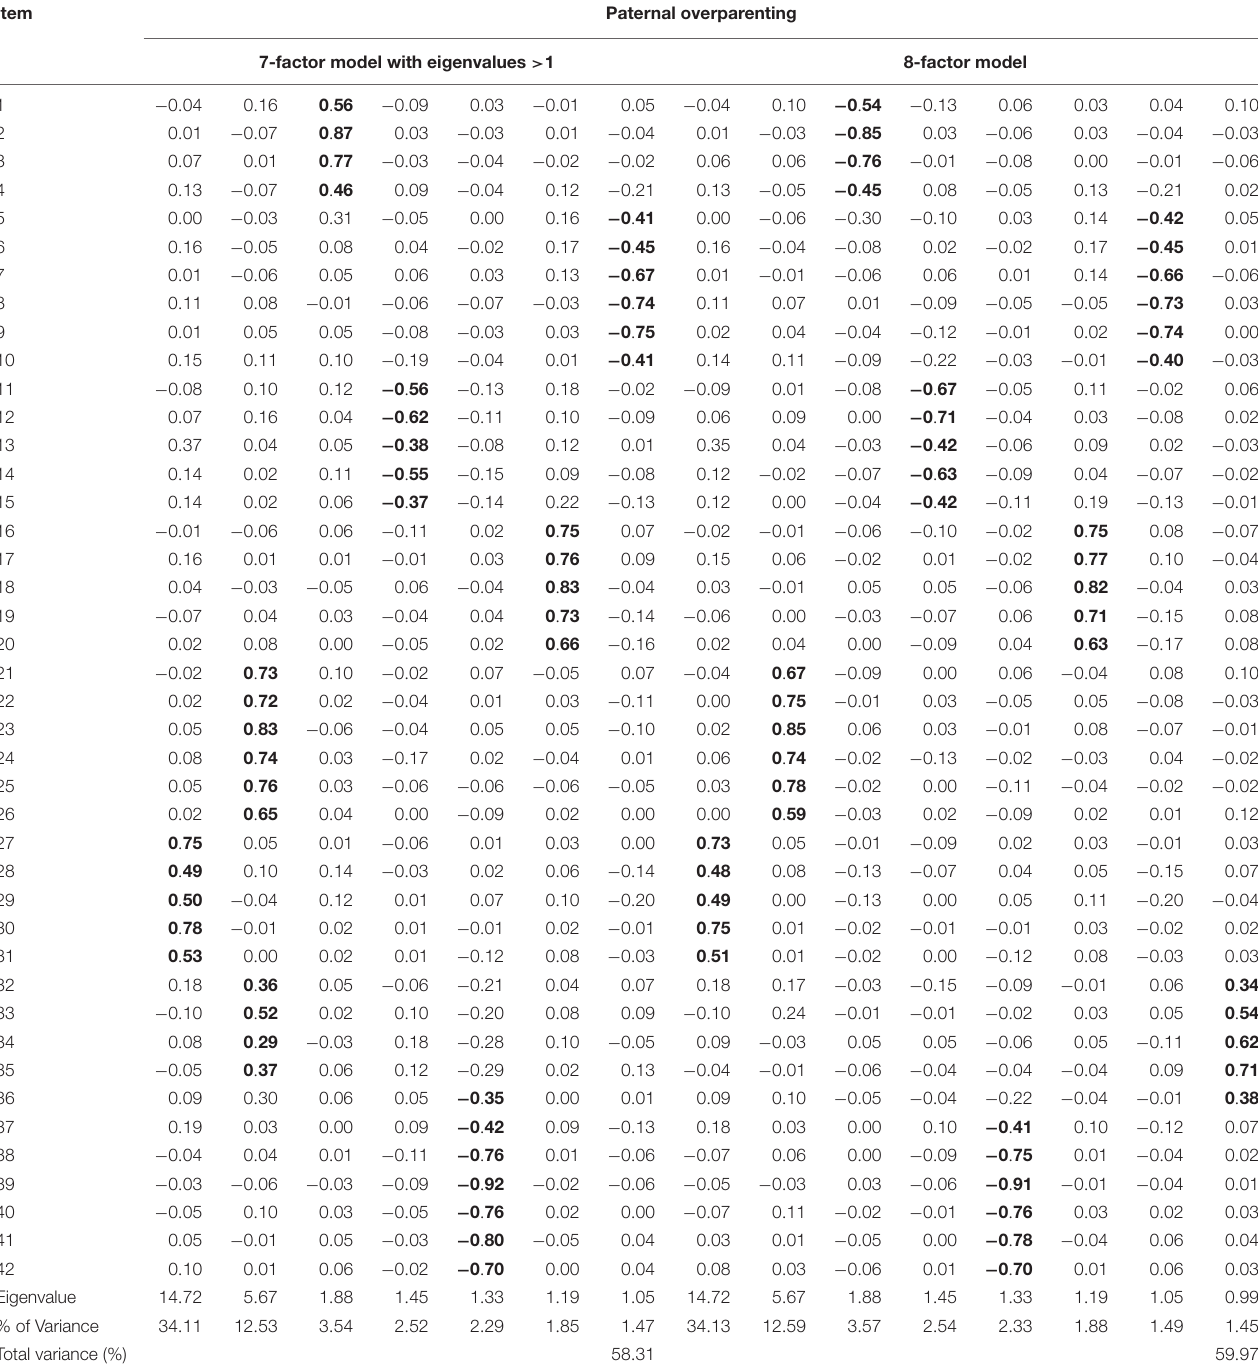
TABLE 3 | Exploratory factor analyses models of Chinese Paternal Overparenting